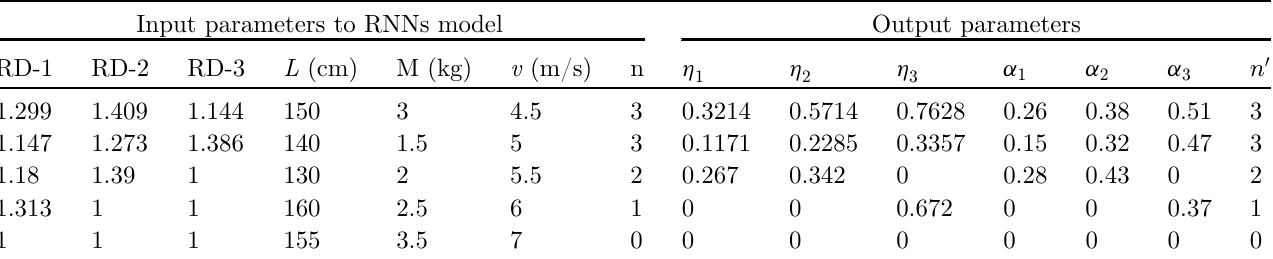
Table 2. Training Patterns for modi fi ed RNNs model.